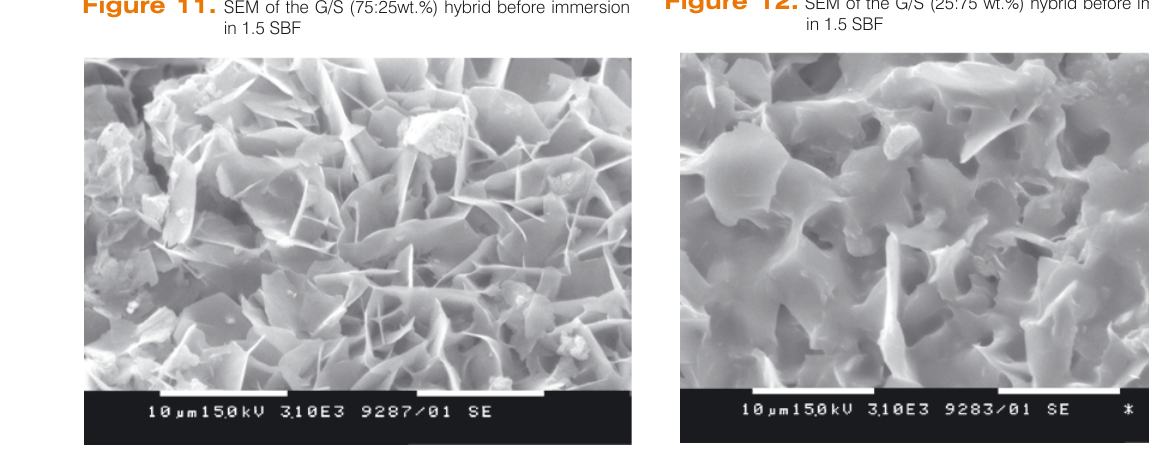
Figure 13. SEM of the G/S (75:25 wt.%) hybrid after immersion in 1.5 SBF